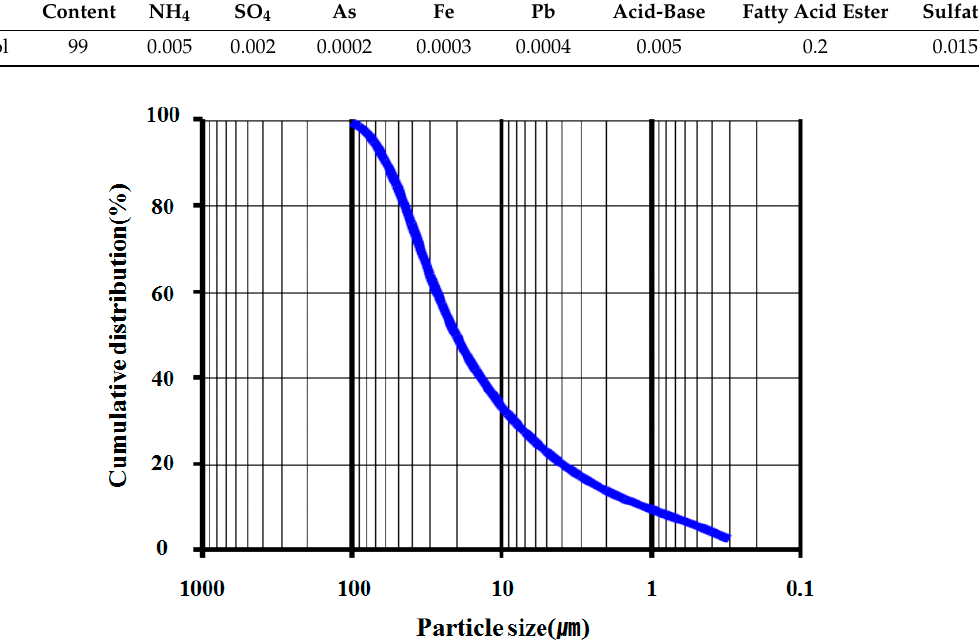
Figure 1. Particle size distribute (Limestone powder).